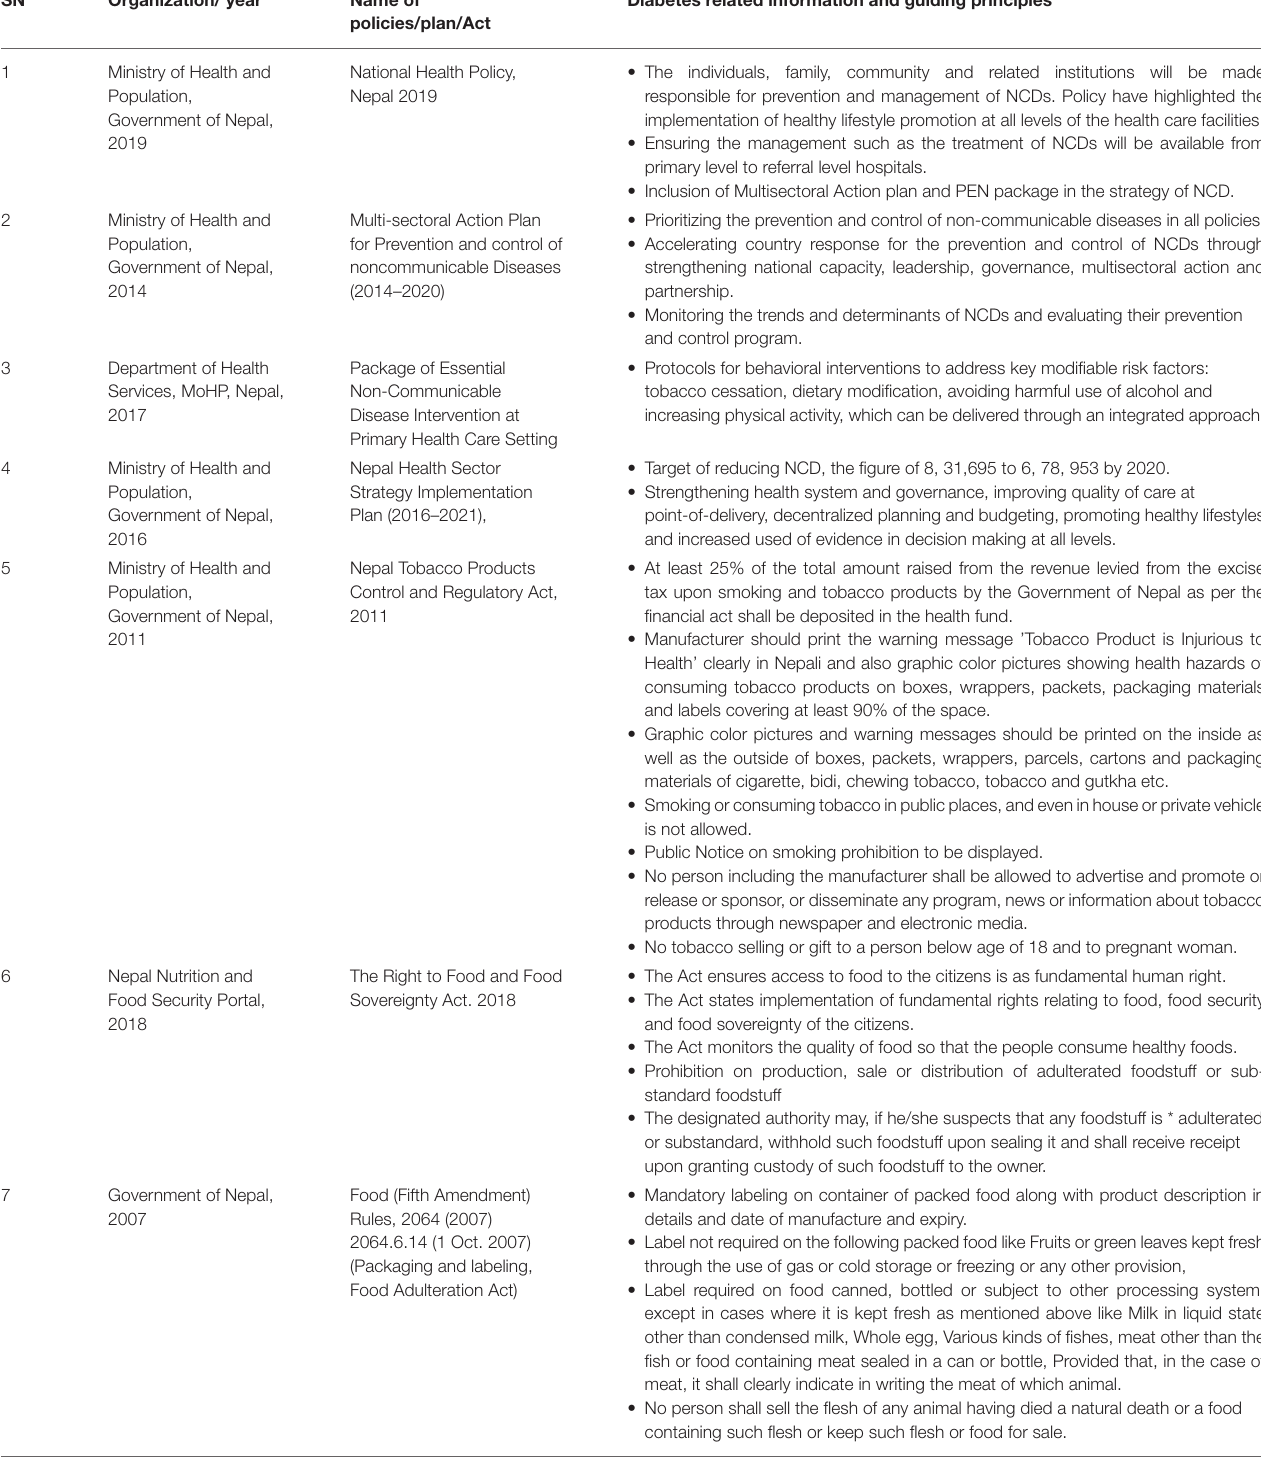
TABLE 2 | Policies and strategies relevant to diabetes prevention and control in